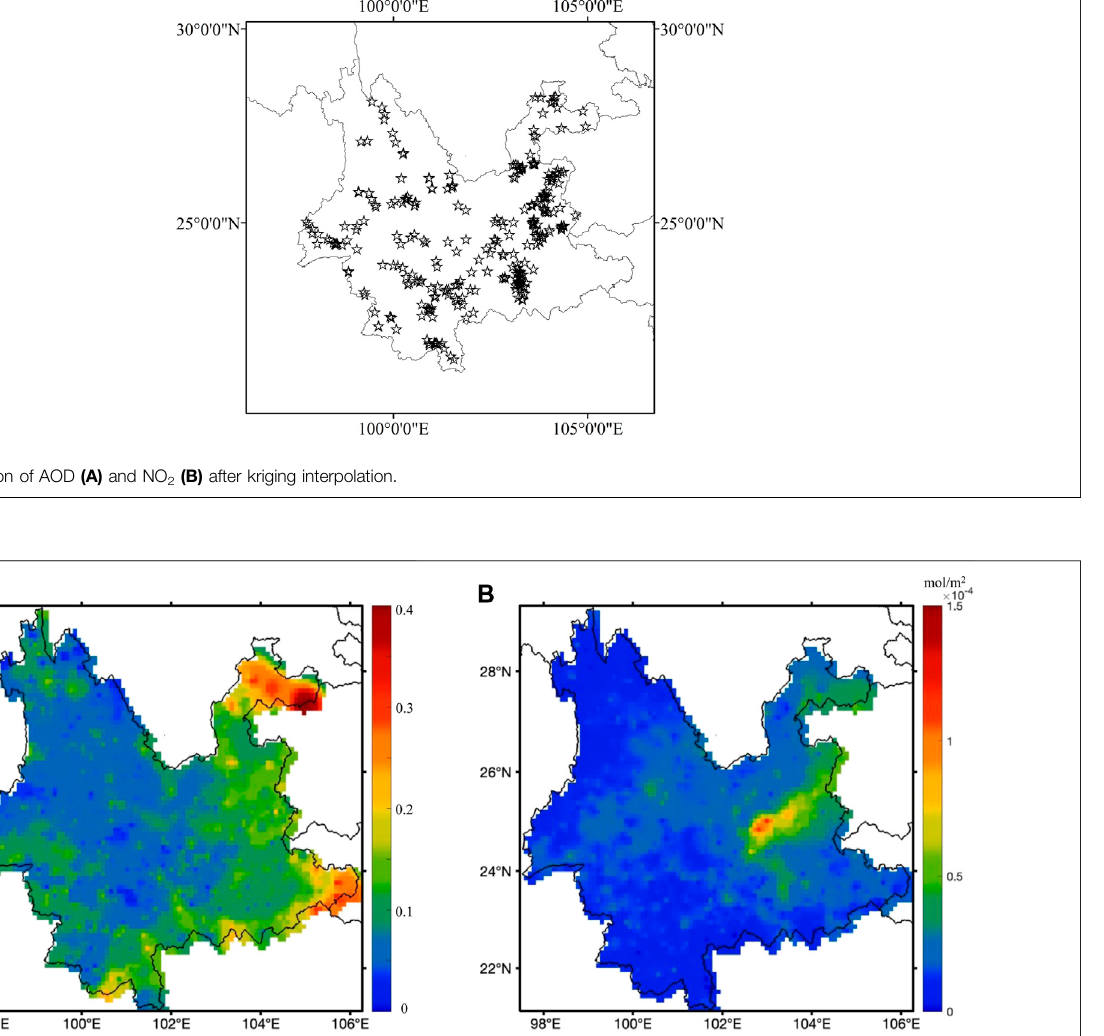
FIGURE 5 | The relationship between the error and the distance for different L